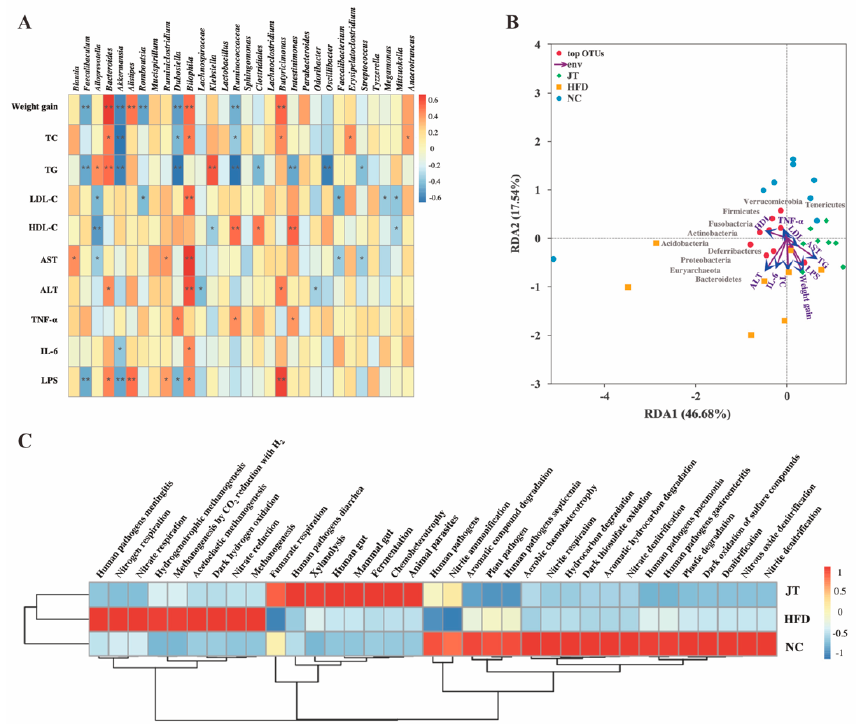
Figure 7. Correlation analysis of gut microbiota and obesity indicators. ( A ) Heatmap of Spearman’s correlation between gut microflora and obesity parameters in mice affected by HFD feeding or CB-JT treatment, * p < 0.05, ** p < 0.01. ( B ) RDA analysis. ( C ) Predictive function profiling of gut micro-